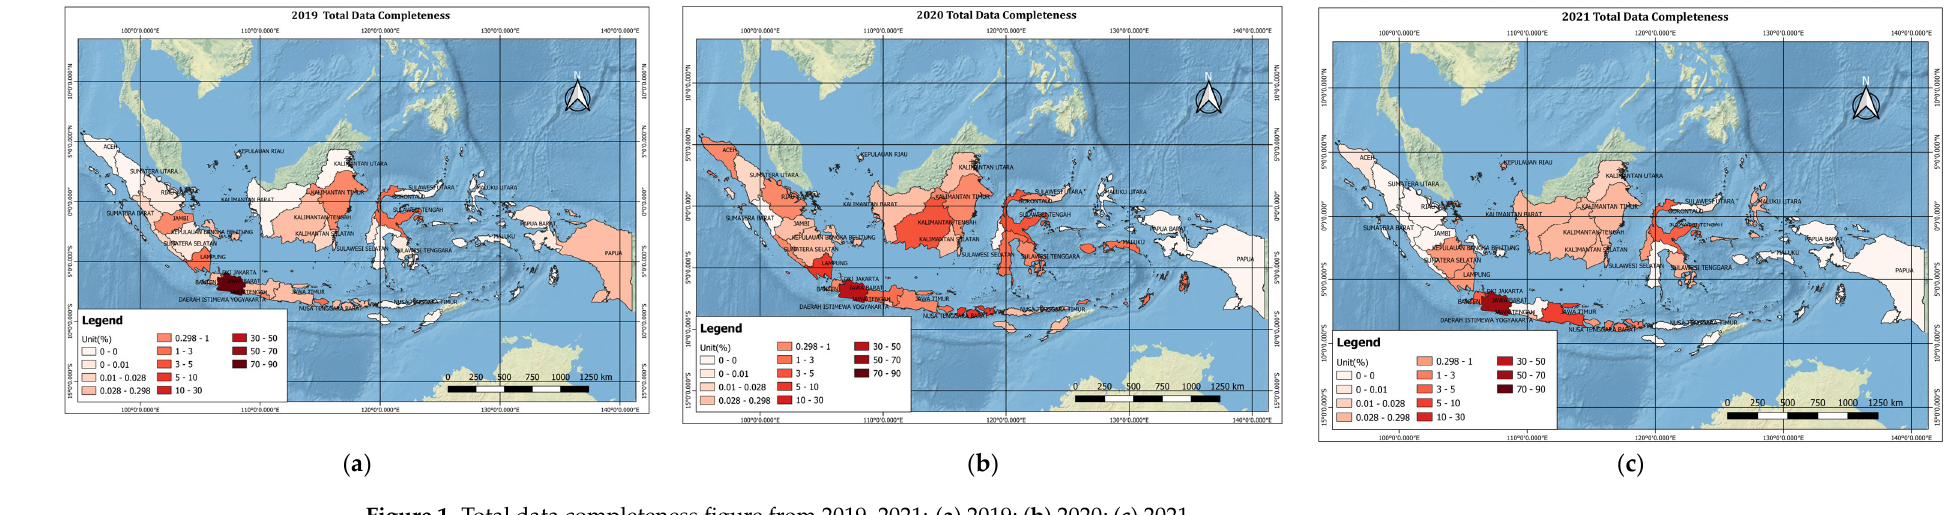
Figure 1. Total data completeness figure from 2019–2021: ( a ) 2019; ( b ) 2020; ( c ) 2021.